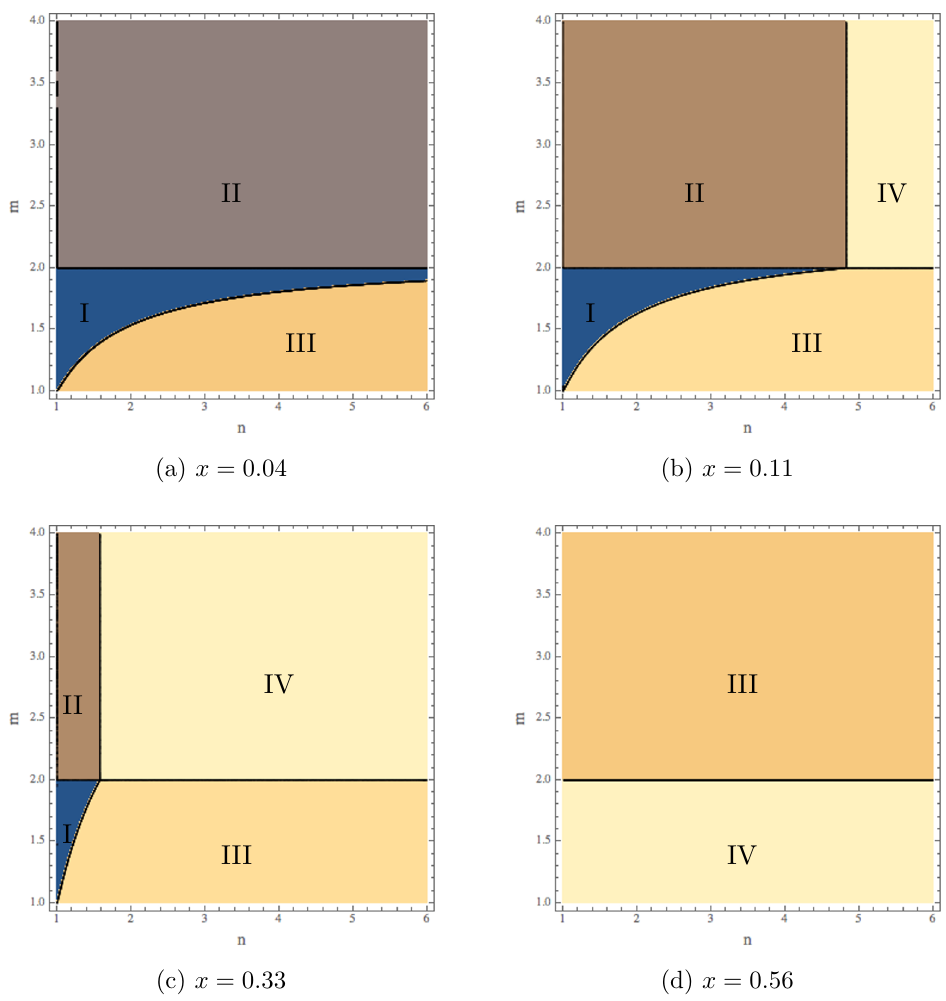
Figure 19 . The phase diagrams for the four phases introduced above. The horizontal axis is n and the vertical is m . Note the flip in the two phases in the last